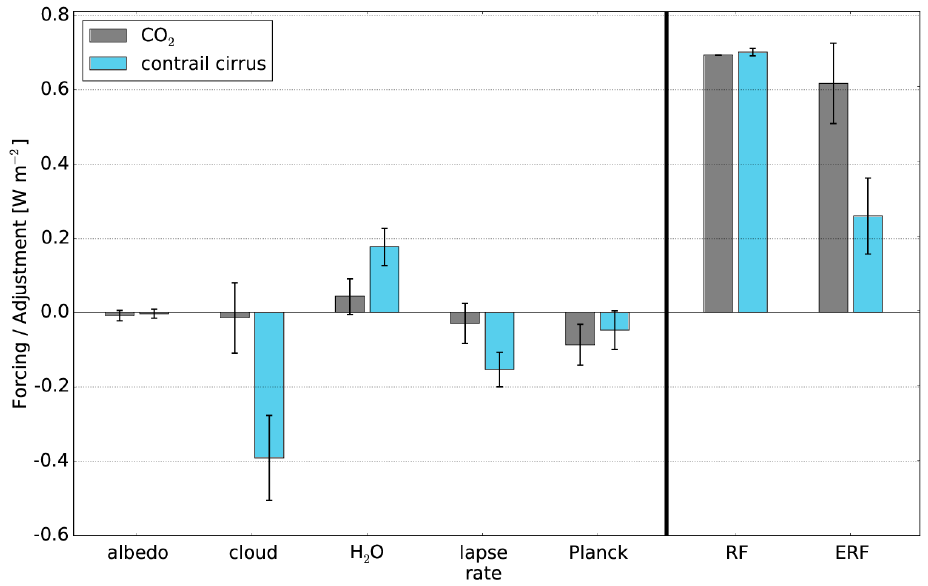
Figure 1. Classical radiative forcing (RF), effective radiative forcing (ERF), and rapid radiative adjustments due to various physical processes (left panel), as yielded by climate model simulations using either contrail cirrus (blue) or CO 2 (gray) as the forcing agent. The simulations are the same as those reported in [16]. The forcings in the simulations were scaled (see text) to ensure statistically significant ERF results. Error bars indicate confidence intervals on a 95% significance level.